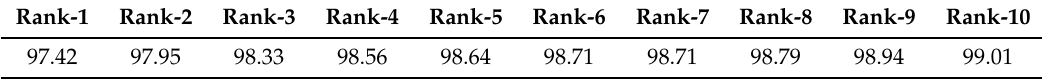
Table 2. Rank scores from 1 to 10 for users on all the building’s floors.